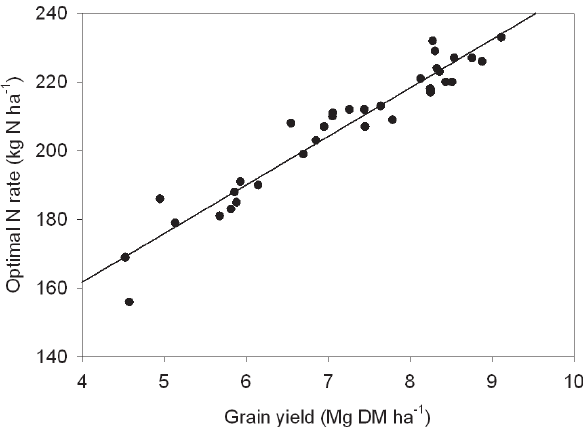
Fig. 2. Regression between the optimal N fertilizer rate and grain yield of winter wheat at the optimal N rate. Based on simulated data of Olesen et al. (2007).